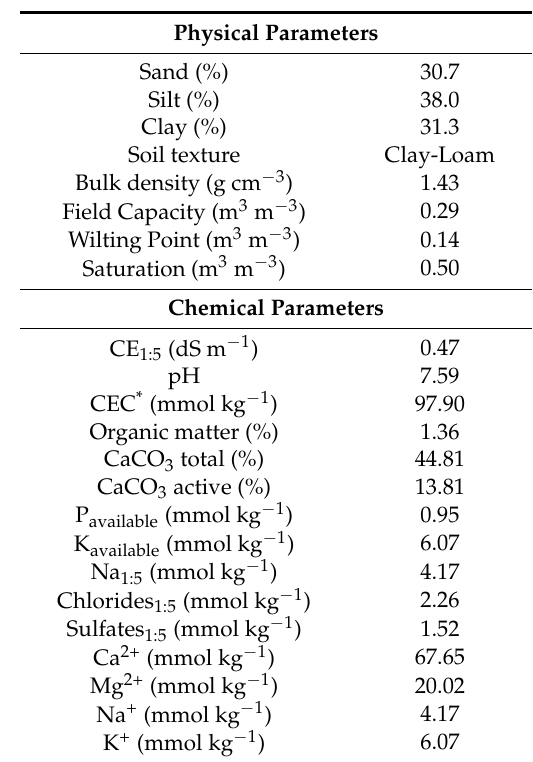
Table 1. Physico-chemical soil analysis of the experimental